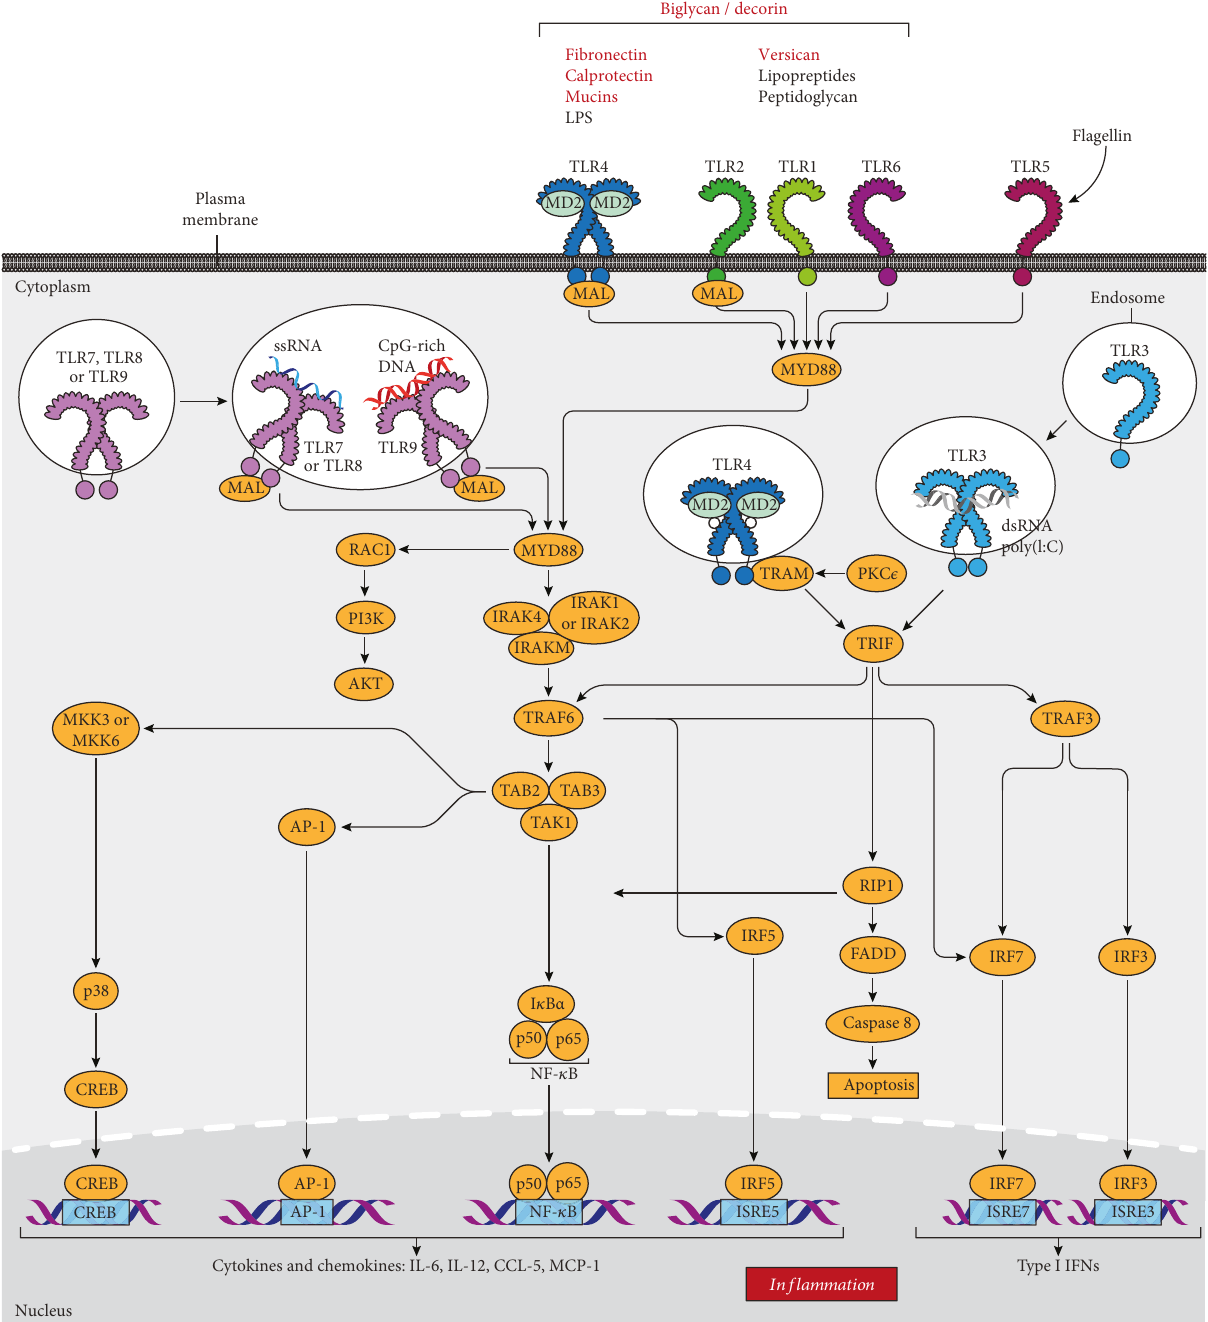
Figure 1: Overview of TLR signaling cascades in SS. TLRs activated in SS and downstream signaling cascades are shown. DAMPs implicated in SS are labeled in